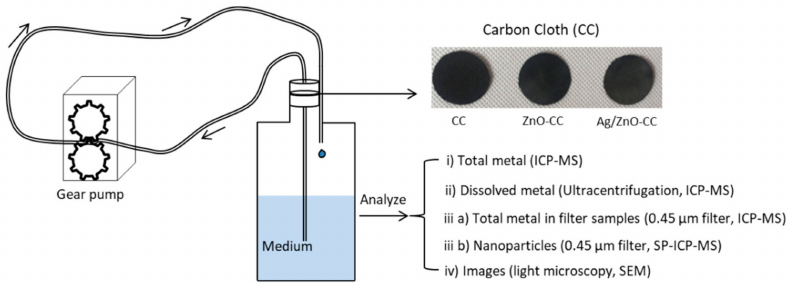
Figure 1. A recirculation flow system for analyzing metals released from the carbon cloth containing Ag / ZnO nanomaterials in MilliQ water and the EPA